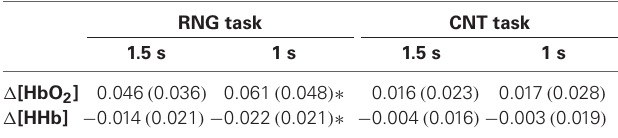
Table 2 | Mean (SD) ∆ [HbO 2 ] and ∆ [HHb] slope coefficients in µ M.cm/s as a function of task and pace .